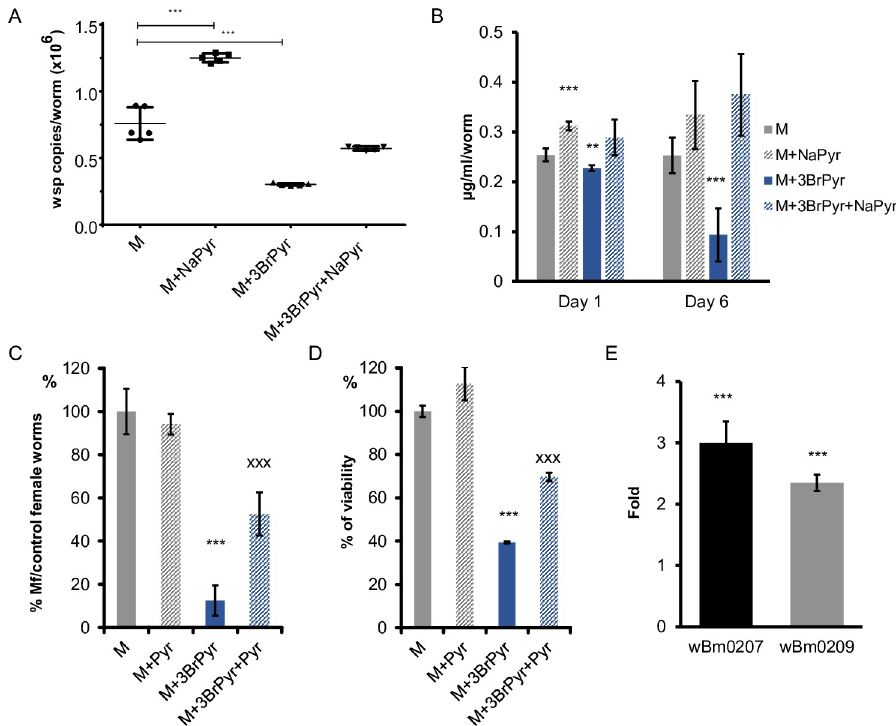
Fig 1. Conditional in vitro treatments of B . pahangi adult worms. A. The wsp copy number per worm in adult males after a 6-day treatment was measured by qPCR. The copy number reflects the abundance of bacteria in treated and control worms ( ��� –p < 0.001). B. Relative changes in the concentration of pyruvate within the worms measured after 1 and 6 days of treatment. Amount of pyruvate is expressed as μ g per ml per worm. ��� –p < 0.001 as compared to relevant control (day 1 or day 6). C. Relative number of Mf released from treated females during the last 2 days of the 6-day treatment. Number of Mf released from control was assigned as 100%. ��� –p < 0.001 as compared to control and xxx –p < 0.001 as compared to M+3BrPyr group. D. Viability of females treated for 6 days. The viability of control worms was taken as 100%. ��� –p < 0.001 as compared to control and xxx –p < 0.001 as compared to M+3BrPyr group.